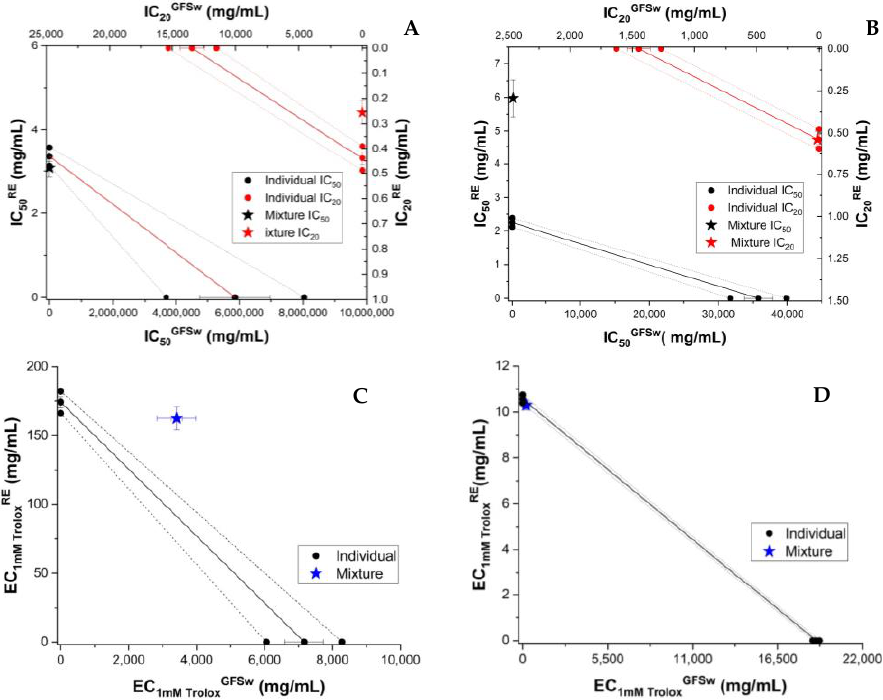
Figure 9. Isobolograms of NaDES (GFSw) and raspberry extract (RE) based on IC 50 (half-maximal inhibitory concentration) and IC 20 (inhibitory concentration at 20% substrate inhibition) for DPPH ( A ), and ABTS ( B ) methods, and based on EC 1mM Trolox (effective concentration at 1 mM Trolox equivalent of the samples) for CUPRAC ( C ) and FRAP ( D ) methods. The error bars from three measurements are shown for each value. Confidence intervals at 95% confidence are shown by dashed lines.